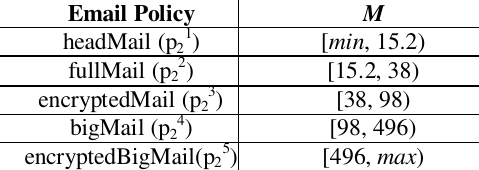
Table 4 Thresholds of Adaptation Mode for Email Email